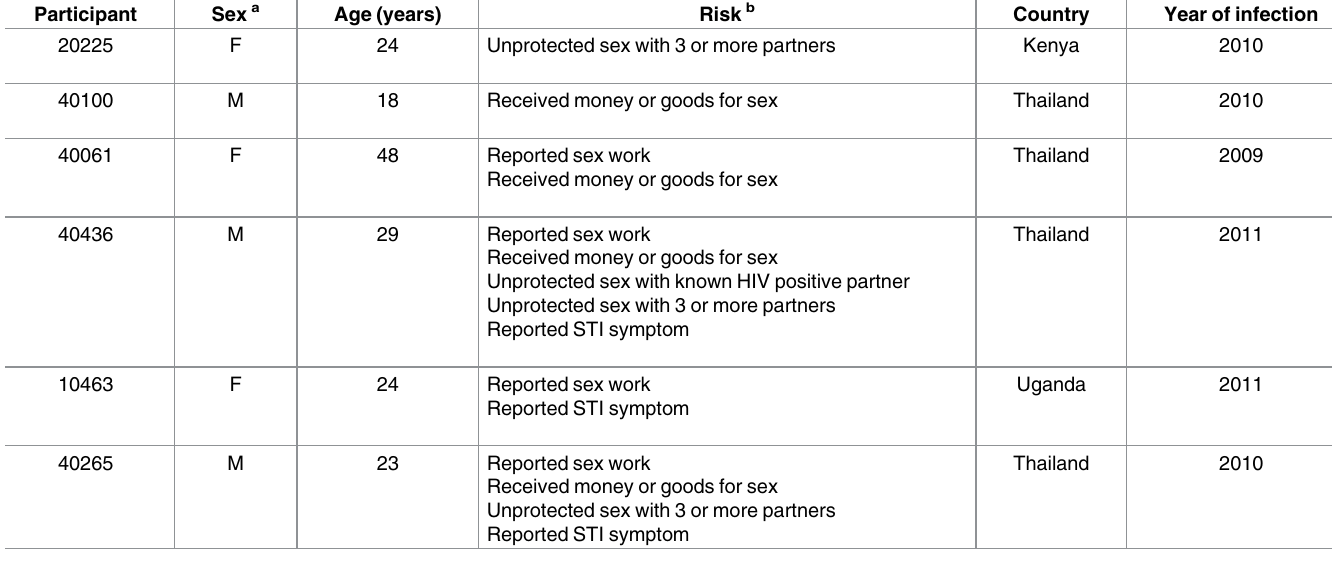
Table 1. Socio-demographic and risk characteristics of 6 participants from the acute HIV-1 infection cohort RV217. Participant